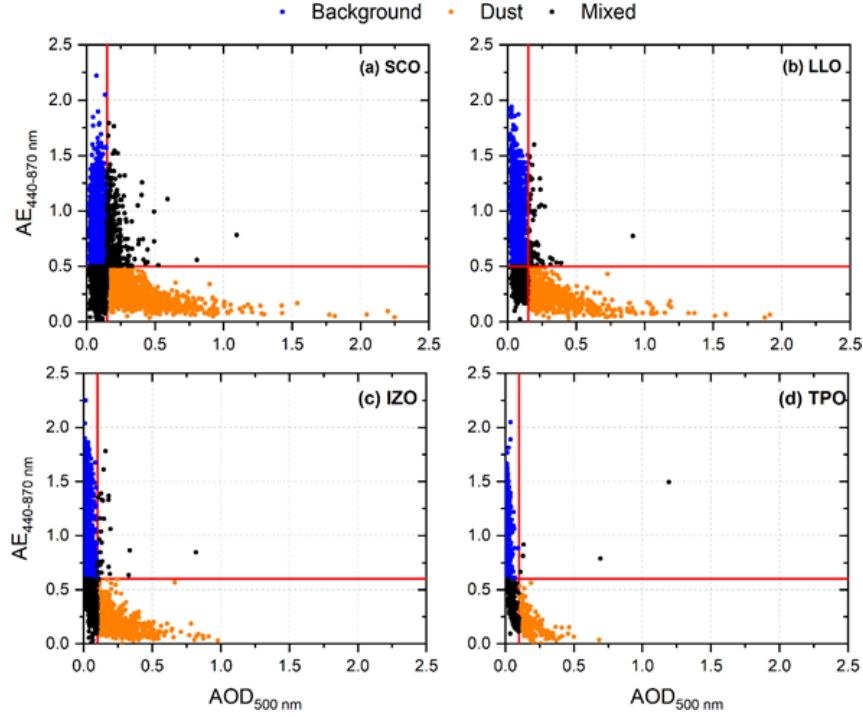
Figure 3. Scatterplots of the daily values of AE 440 − 870nm versus AOD 500nm at (a) SCO, (b) LLO, (c) IZO and (d) TPO. In (a) and (b) , the red lines indicate the threshold limits established for background conditions (AOD 500nm < 0 . 15 and AE 440 − 870nm > 0 . 50 (blue dots)) and for the dust-laden scenario (AOD 500nm ≥ 0 . 15 and AE 440 − 870nm ≤ 0 . 50 (orange dots)) at SCO and LLO. Similarly, in (c) and (d) , the red lines indicate the threshold limits for background conditions (AOD 500nm < 0 . 10 and AE 440 − 870nm > 0 . 60 (blue dots)) and the dust-laden scenario (AOD 500nm ≥ 0 . 10 and AE 440 − 870nm ≤ 0 . 60 (orange dots)) for IZO and TPO. Black dots indicate the presence of mixed